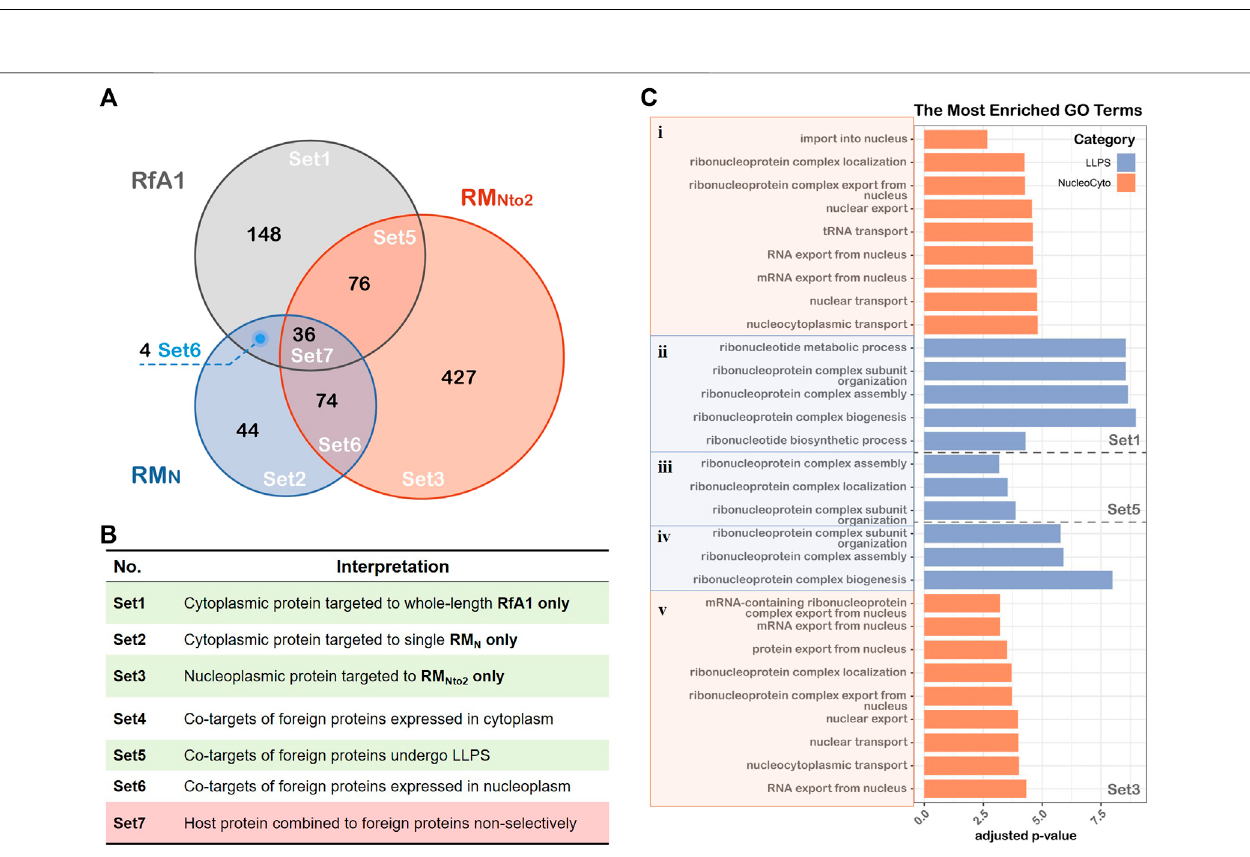
FIGURE 4 | GO biological processes annotation of proteins associated with LLPS and cellular localization. (A) Venn diagram showing the results of LC-MS, the graphisdividedintoSet1~Set7basedoninclusion-exclusion principleofdatasets. (B) InterpretationsofdifferentsetsintheVenngraph. (C) GenelistsinSet1,Set5and Set3 are converted to ENTREZ ID, and R package clusterPro fi ler is used to perform Gene Ontology annotation. LLPS and cellular localization-associated BP terms are showed in the fi gure, and the thresholds set as log 10 (adjusted p -value) < − 2.5.